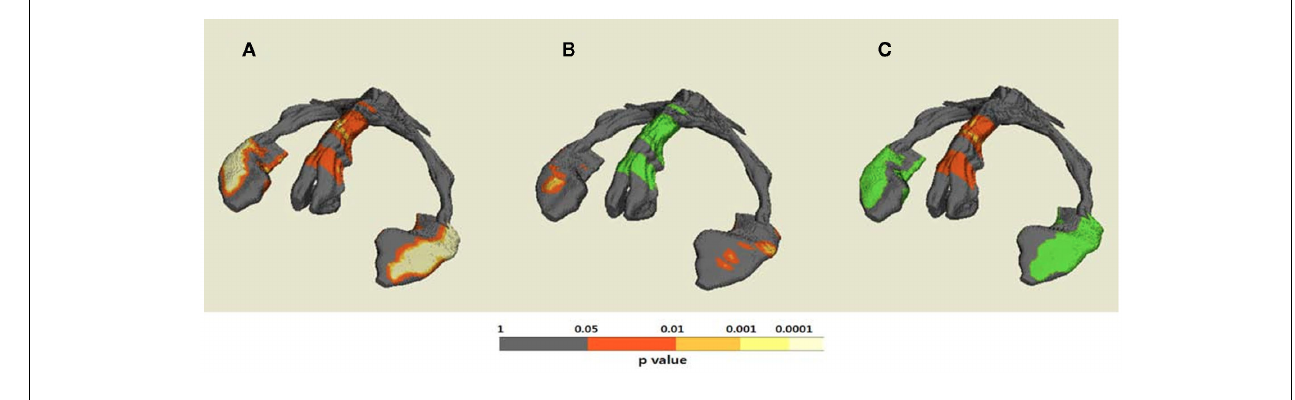
FIGURE 4 | Demonstrative maps showing both anatomical fornix–hippocampus relationship and statistical association between fornix and hippocampus alteration on the same 3D template hippocampus–fornix surface. (A) Statistical p -value (corrected for multiple comparison) maps for cognitively normal (CN) vs. Alzheimer’s disease (AD) differences of both regional fornix fractional anisotropy (FA)